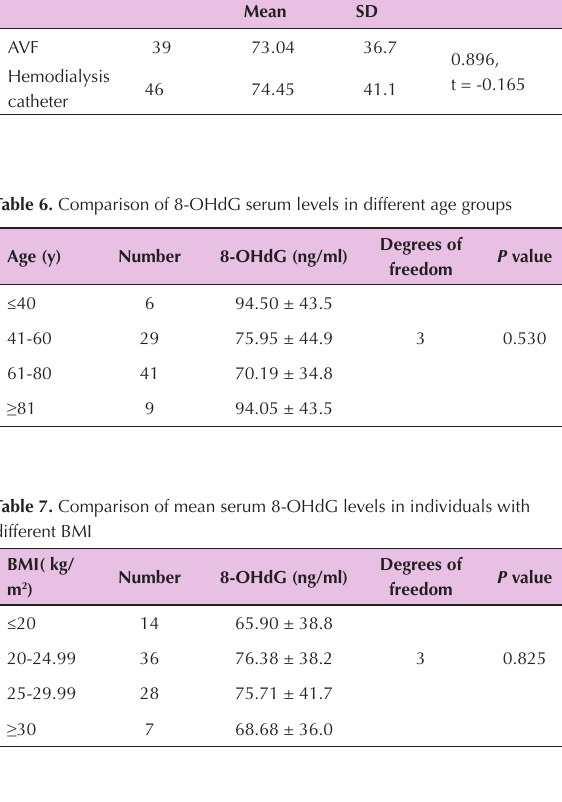
Table 5. Comparison of mean serum 8-OhdG levels based on hemodialysis access Gender